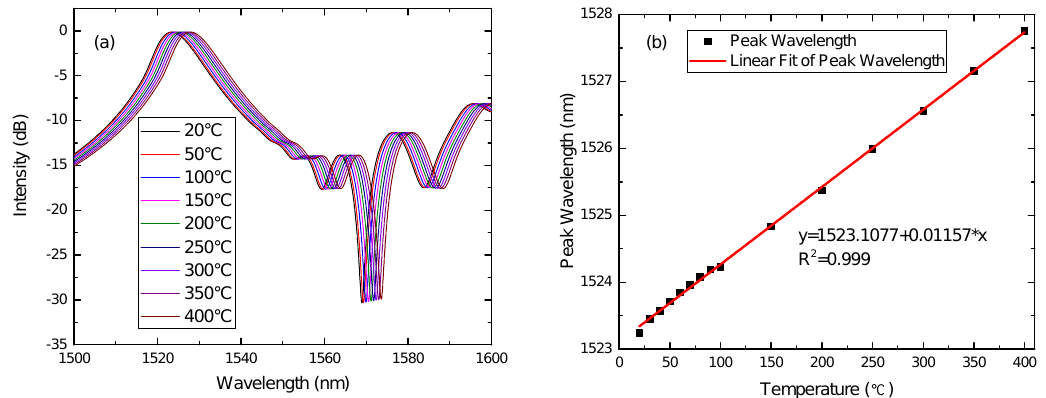
Figure 5. a NCF = 62.5 µ m and z NCF = 59 mm. ( a ) The calculated transmission spectra as the temperature increases and ( b ) the response between the peak wavelength and temperature and the linear fitting.